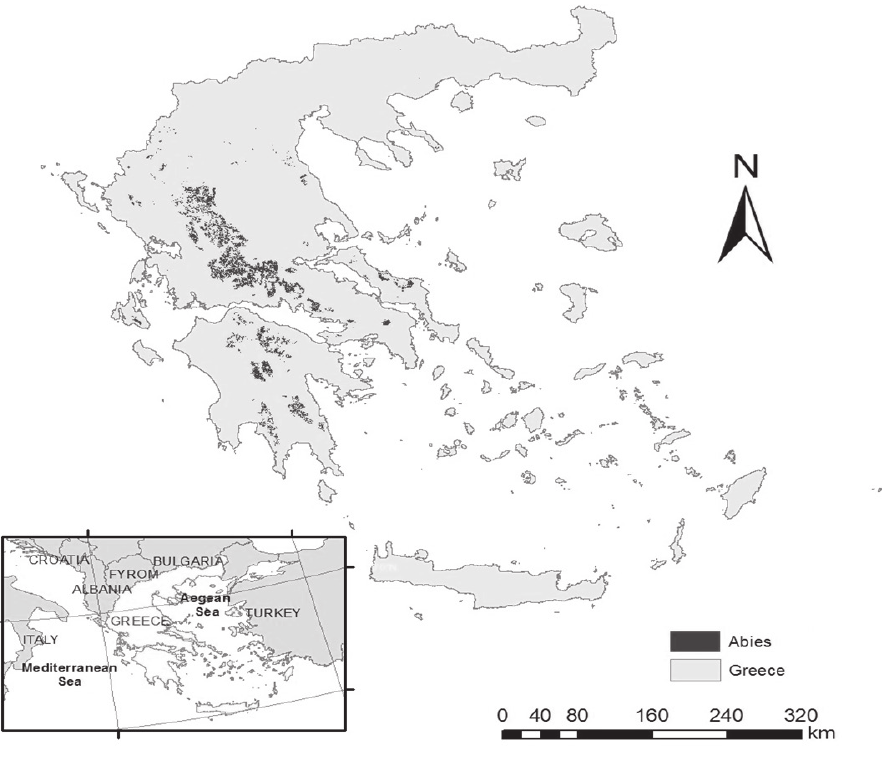
FIGURE 1. Geographical distribution of fir forests in